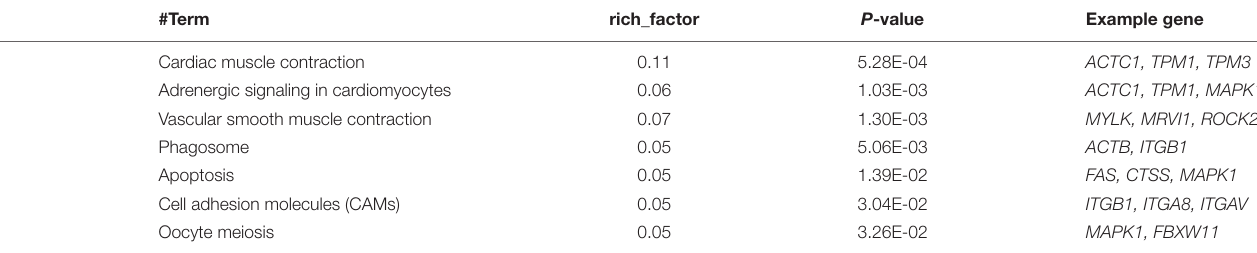
sample. TABLE S1 | Soft power estimated according to TOM. TABLE S2 | Primers for the validation of circRNAs or RT-qPCR. TABLE S3 | Quality control results for circRNAs and mRNAs.